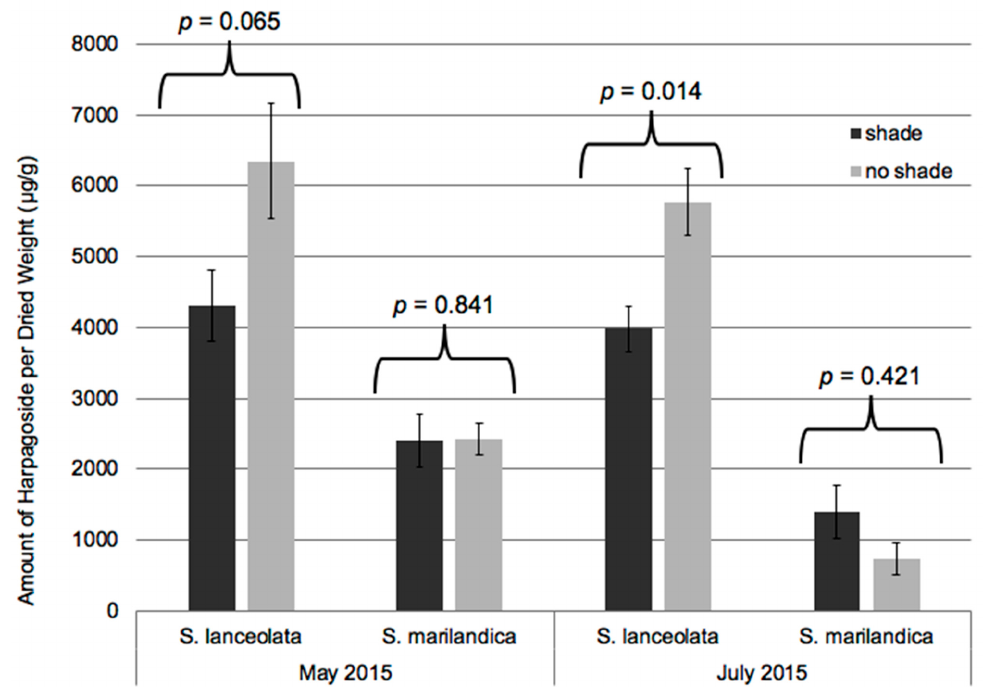
Figure 3. UPLC-PDA quantification of harpagoside content in the leaves of S. lanceolata and S. marilandica plants subjected to no shade and shade treatment that were harvested in May 2015 and July 2015. The vertical error bars represent standard errors of five biological replicates (n = 5). Statistical significance ( p ≤ 0.05) was determined by independent/unpaired two-sample t -test. Since the Shapiro–Wilk test determined that the S. marilandica groups were not normally distributed, p -values for these groups were calculated by the Wilcoxon test.